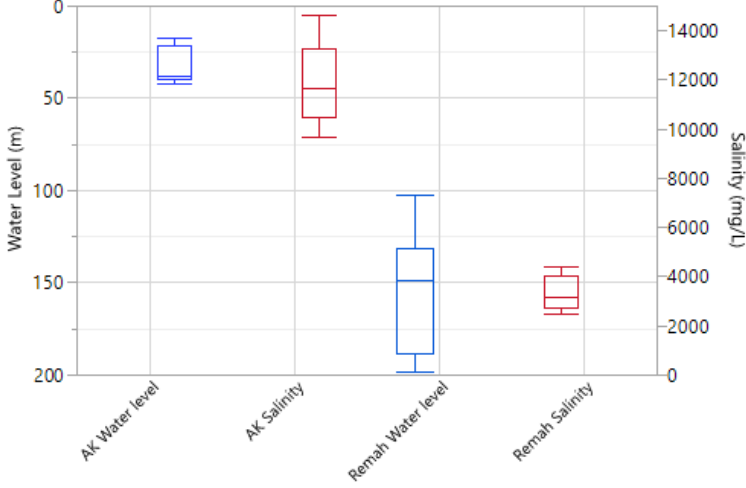
Figure 11. Box plot comparing groundwater level and salinity of Remah and Al Khatim.